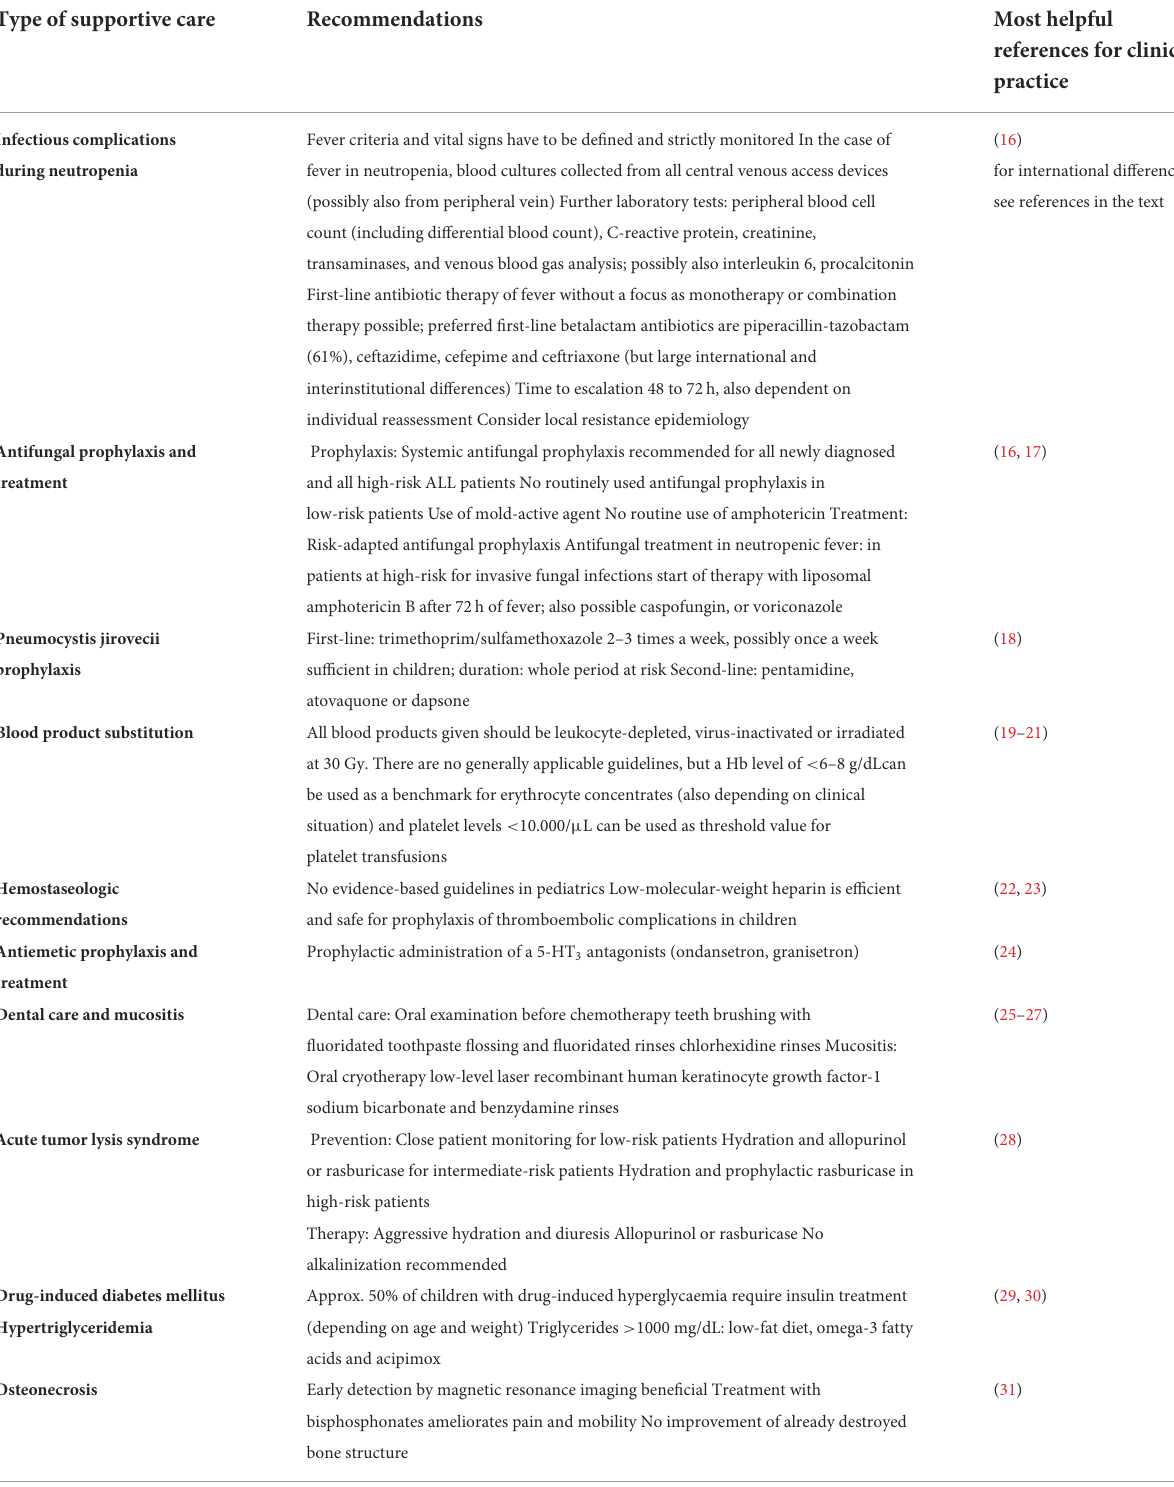
TABLE 1 Compilation of relevant guidelines and recommendations for supportive measures in conventional ALL